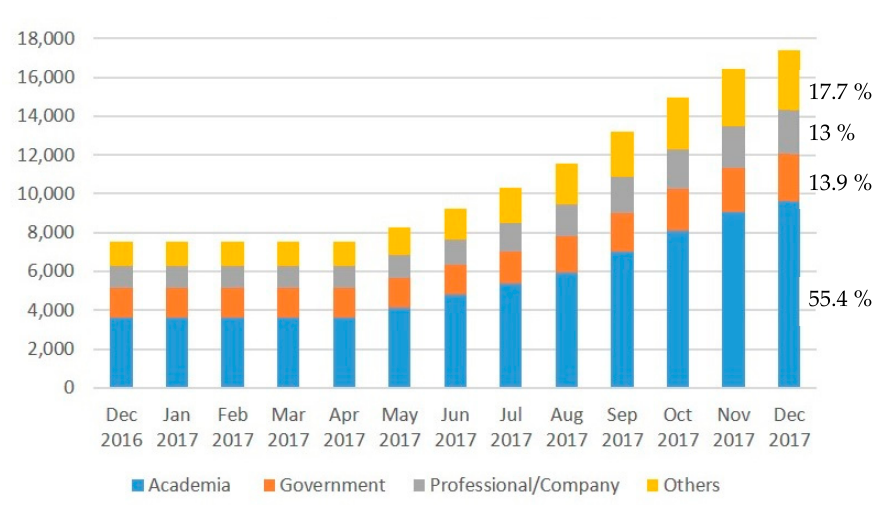
Figure 2. Ina-Geoportal users by type of institution.